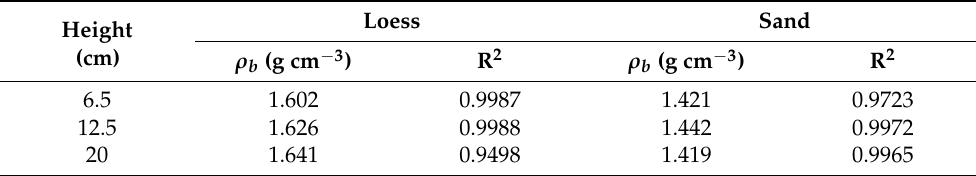
Table 3. Fitting results of ρ b at different locations in the sand and loess.